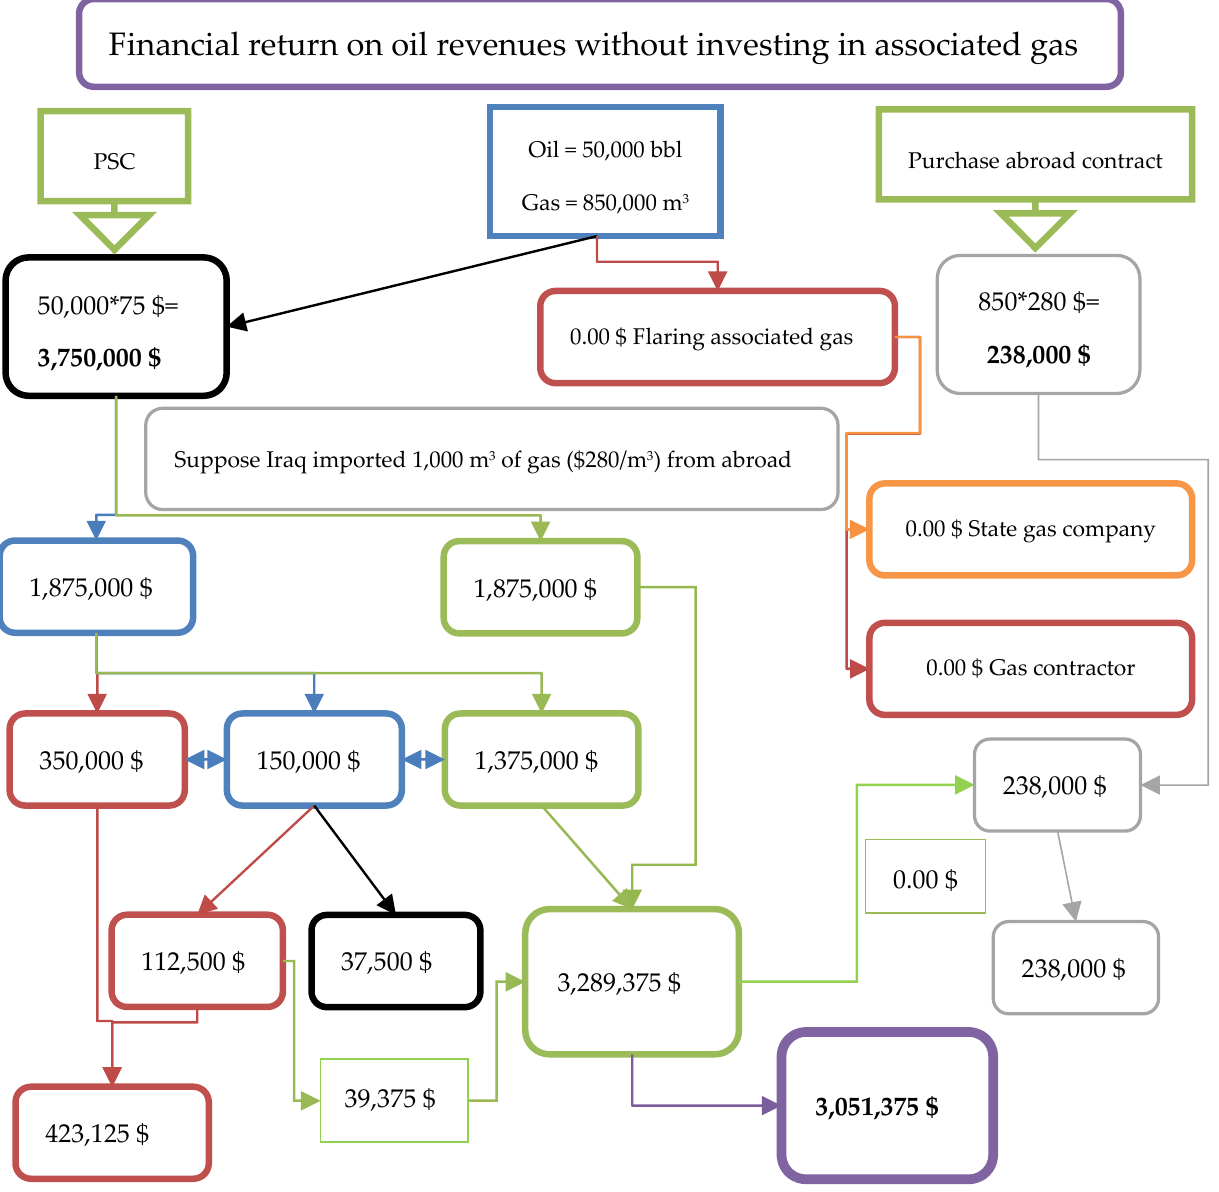
Figure 5. Financial return on oil without investing in associated gas, importing it from abroad instead. Oil revenues account for 95% of the Iraqi budget.